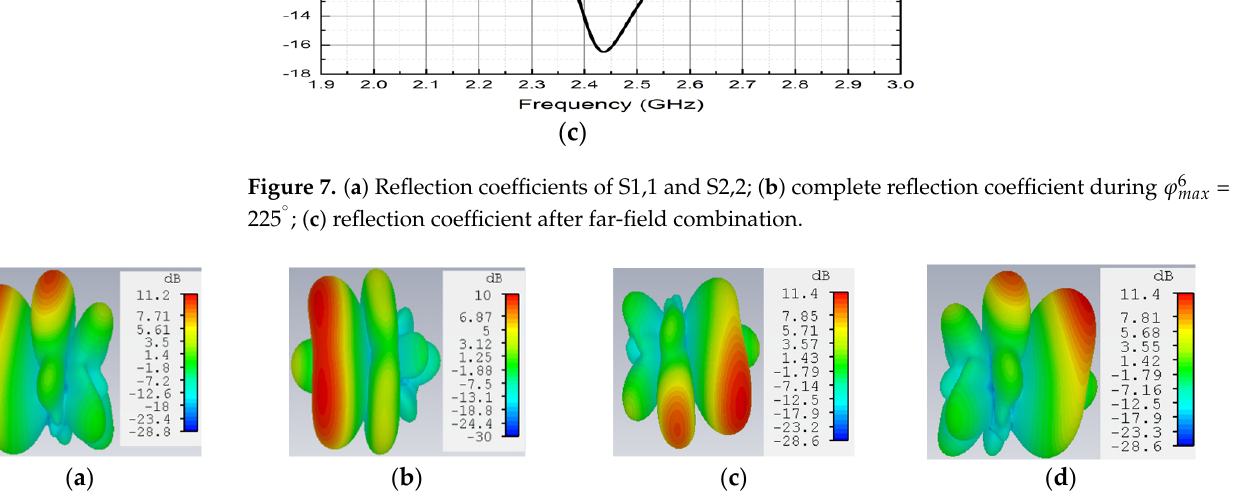
Figure 8. 3D radiation patterns of the antenna at: ( a ) 45 ◦ ; ( b ) 90 ◦ ; ( c ) 225 ◦ ; ( d ) 315 ◦